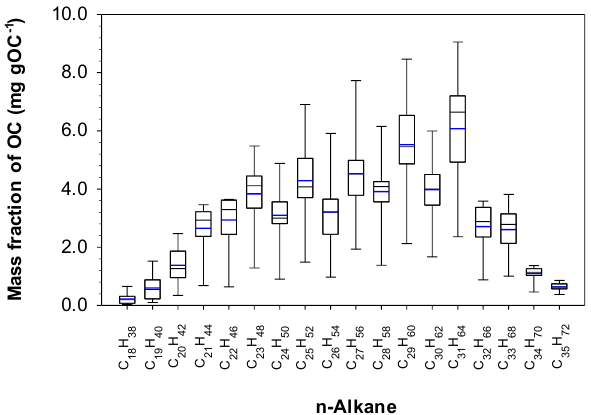
Figure 4. Molecular distribution of n -alkanes for selected plumes ( n = 10). Y axis indicates individual n -alkane mass fraction of OC. The horizontal lines (black) in the box represent the 25th, 50th (me- dian), and 75th percentiles and mean values are indicated by the blue